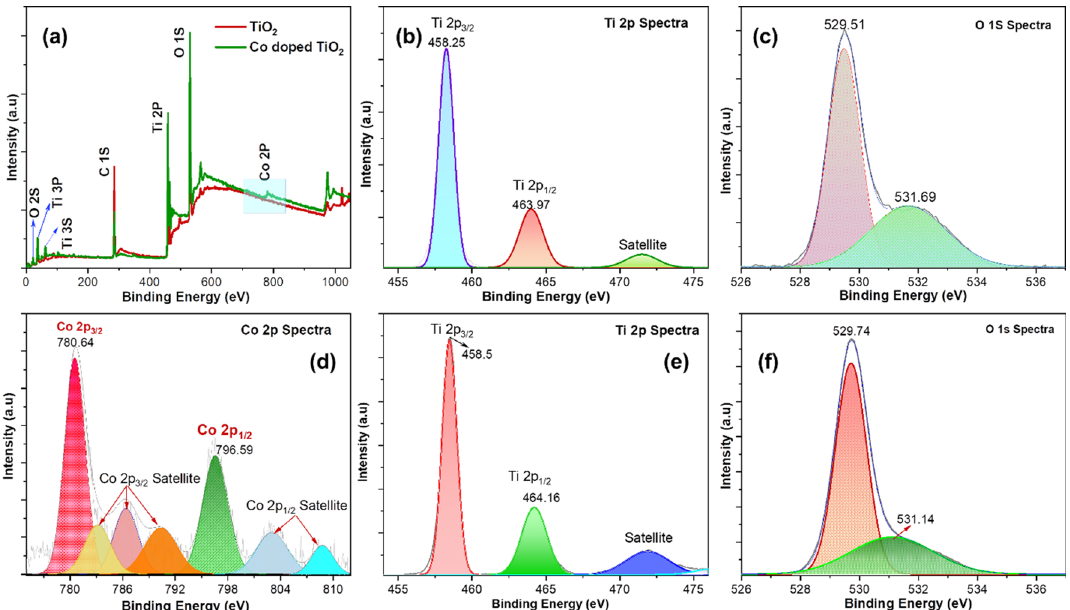
Figure 5. ( a ) A comparative XPS survey spectra of MOF derived TiO 2 and cobalt doped TiO 2 ( b – f ) Core spectra of Ti, O and